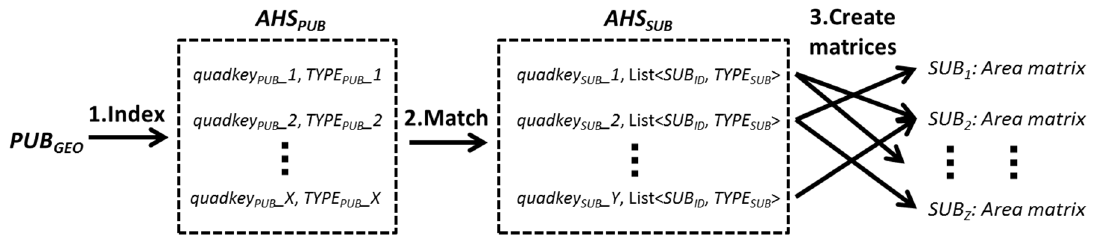
Figure 2. The workflow for intersecting the geometry of publication.